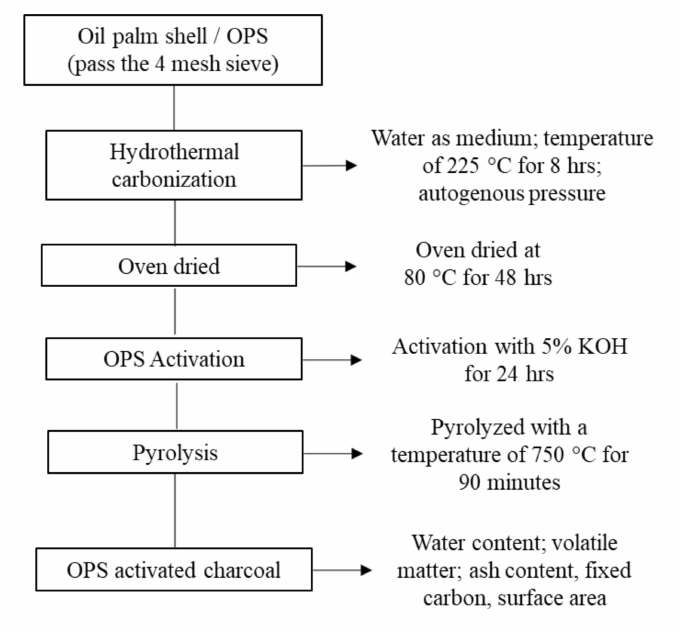
Figure 2. The flowchart of the manufacture and characterization of OPS-activated charcoal. Table 1. The characteristics of EFB hydrochar and OPS-activated